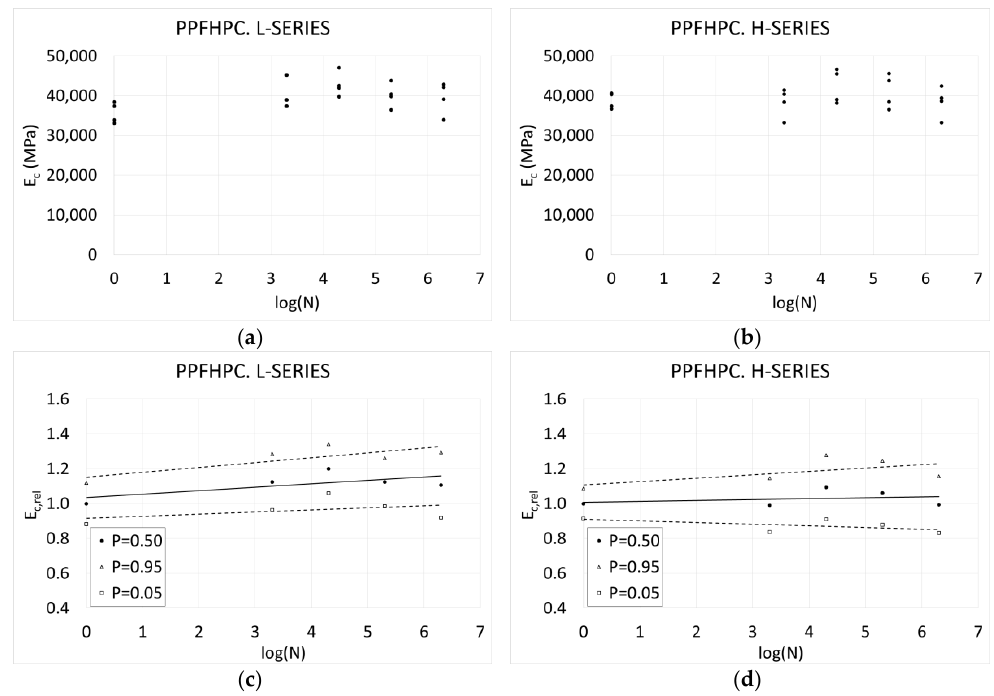
Figure 9. Variation of the compressive modulus of elasticity with the number of cycles. PPFHPC ( a ) L-Series. Raw values. ( b ) H-Series. Raw values. ( c ) L-Series. Maximum, minimum, and average relative values, and tendency lines. ( d ) H-Series. Maximum, minimum, and average relative values, and tendency